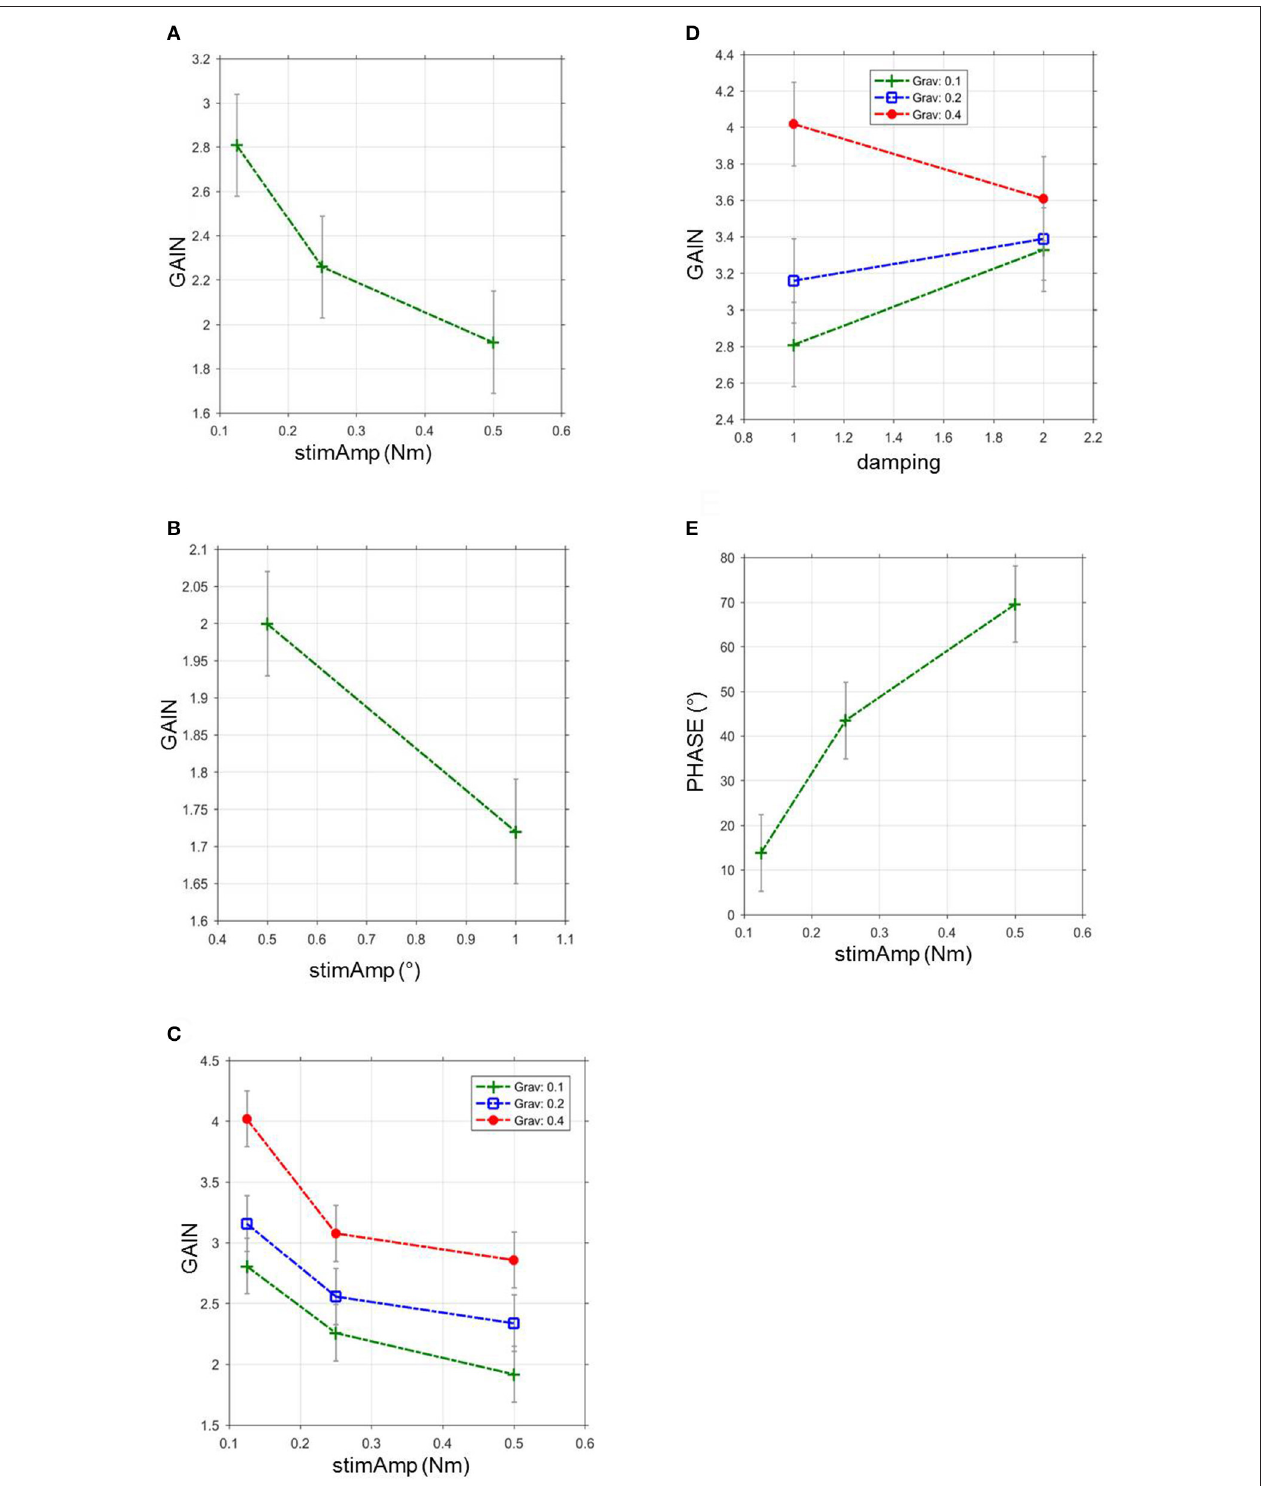
FIGURE 4 | GAIN and PHASE in relation to stimulus amplitude, gravitational force and damping during virtual balancing and free stance. (A) GAIN during virtual balancing as a function of stimulus amplitudes in Nm across all visual conditions and body segments, stimAmp , stimulus amplitude. (B) GAIN during free stance as a function of stimulus amplitudes in degrees across all visual conditions and body segments, stimAmp , stimulus amplitude. ◦ , degree. (C) Influence of gravitational force and stimulus amplitude on GAIN during virtual balancing, Grav , gravitational force (D) Influence of gravitational force and damping on GAIN during virtual balancing. (E) Relation between stimulus amplitude and PHASE during virtual